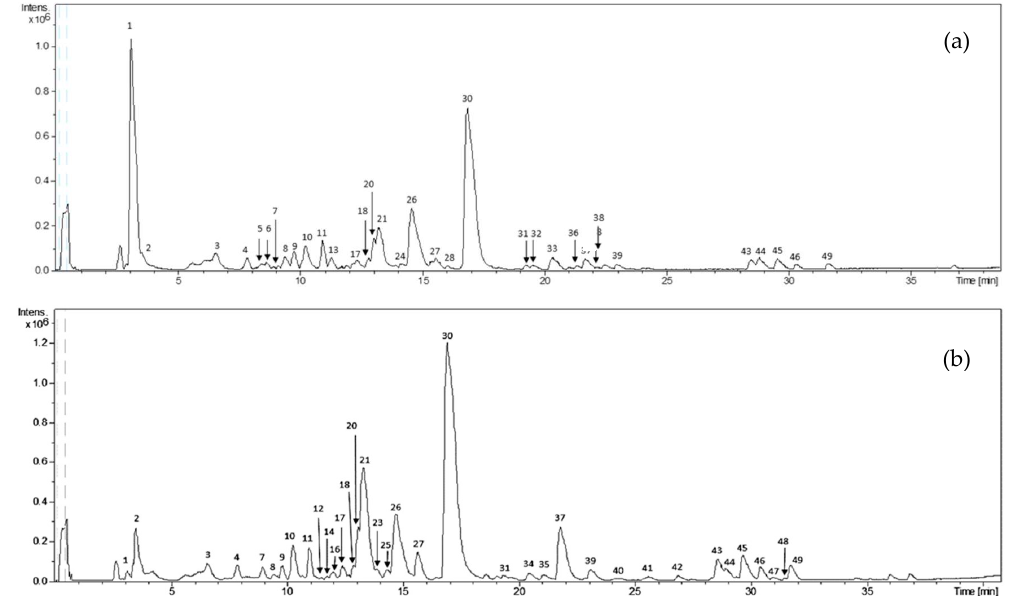
Figure 1. Base peak chromatograms of representative husk ( a ) and bean ( b ) extracts obtained by high-performance liquid chromatography coupled to electrospray ionization and time-of-flight mass spectrometry (HPLC-ESI-TOF-MS).